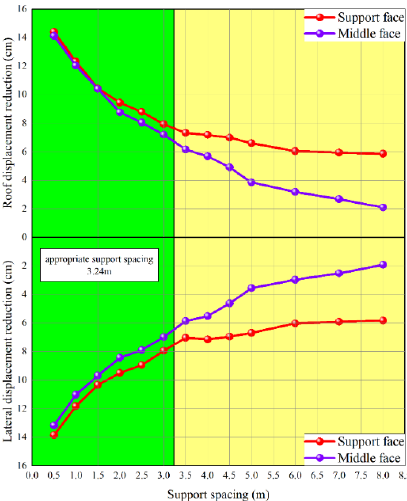
Figure 5. Displacement reduction of the support face and the middle support under the radial support.